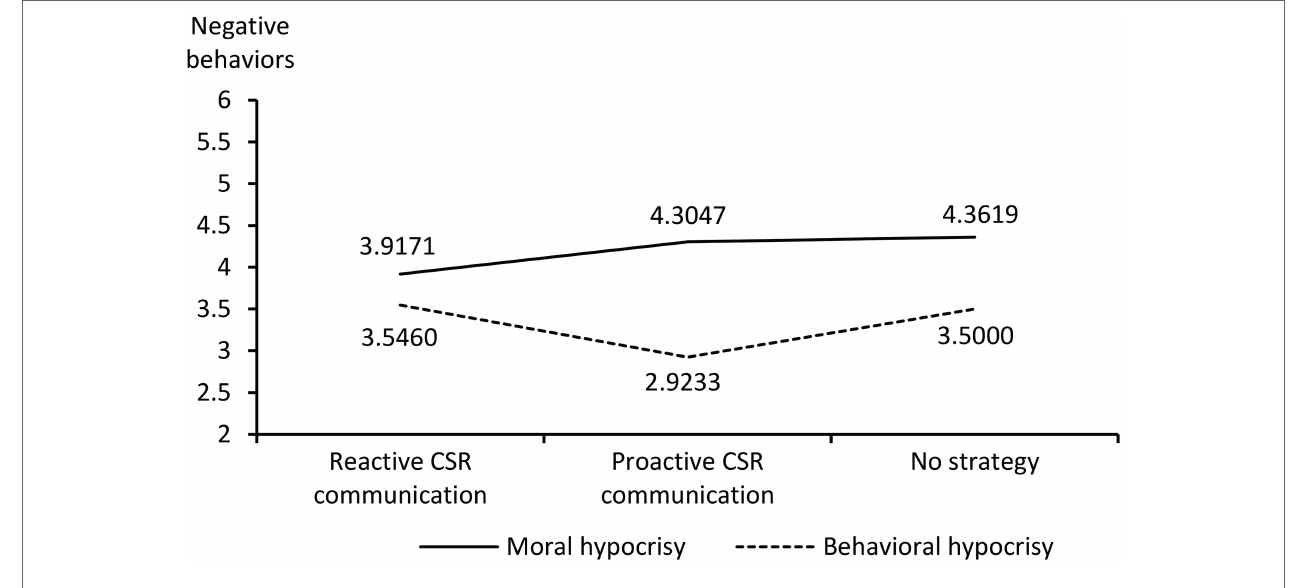
FIGURE 3 | Trend of negative behaviors.